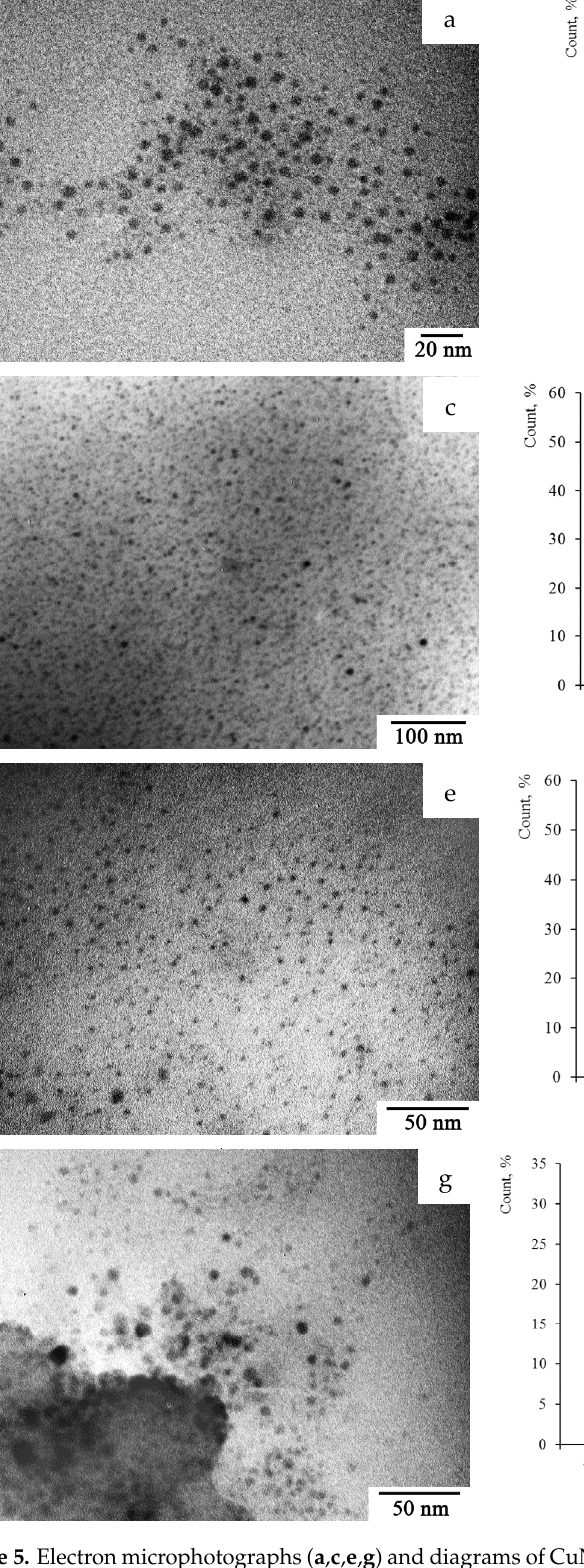
Figure 5. Electron microphotographs ( a , c , e , g ) and diagrams of CuNPs size distribution ( b , d , f , h ) of polymer nanocomposites: 1 ( a , b ), 2 ( c , d ), 3 ( e , f ), and 4 ( g , h ).